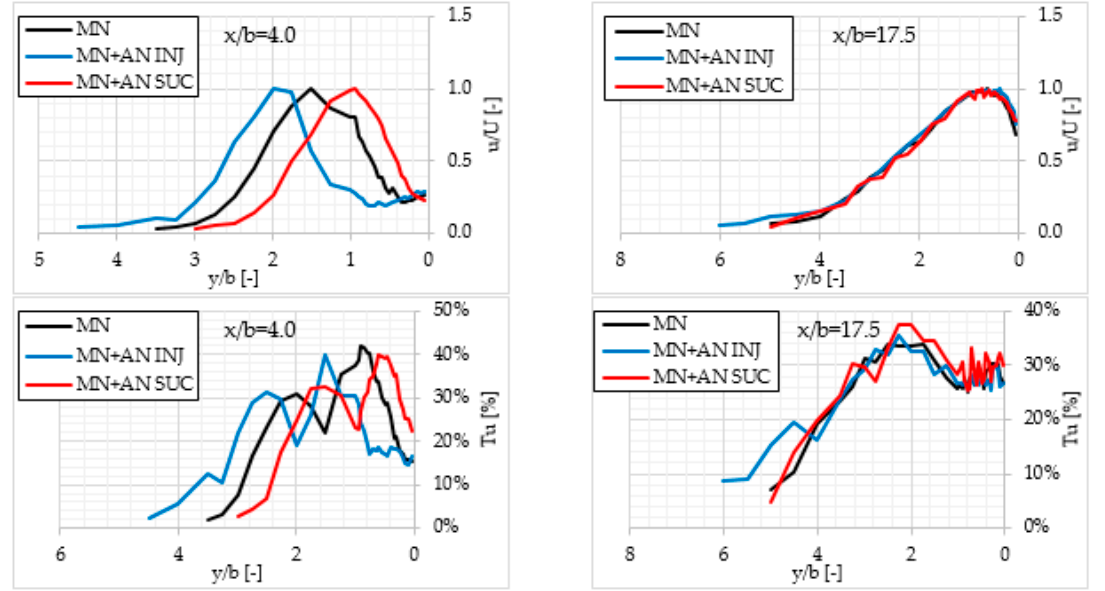
Figure 7. Ratio of average velocity u to exit velocity U , and turbulence Tu at x/b = 4.0 and x/b = 17.5. The interactions between the MN and the AN influenced jet geometry (Figure When the AN was operated in suction mode (case 3), the jet became reattached to the plate already at around x/b = 6.0. In case 1, when only the MN was in use, the jet was reattached at x/b = 7.5, whereas in case 2, the jet was reattached at around x/b = 9.0 (Figure